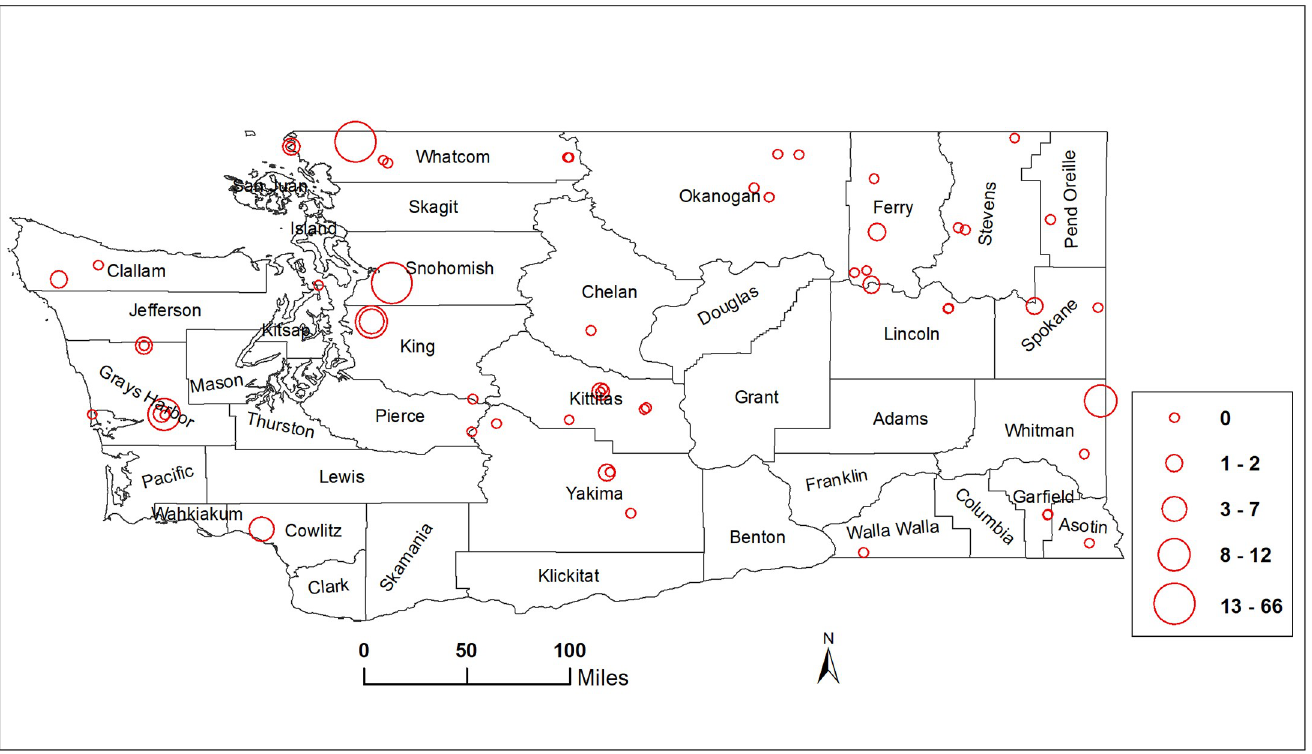
Fig 3. Abundance of R . pomonella in Washington State, U.S.A. Abundance data collected at 61 sites in 2015 and 2016 were averaged and classified into 5 classes using the natural breaks classifier in ArcGIS [43].